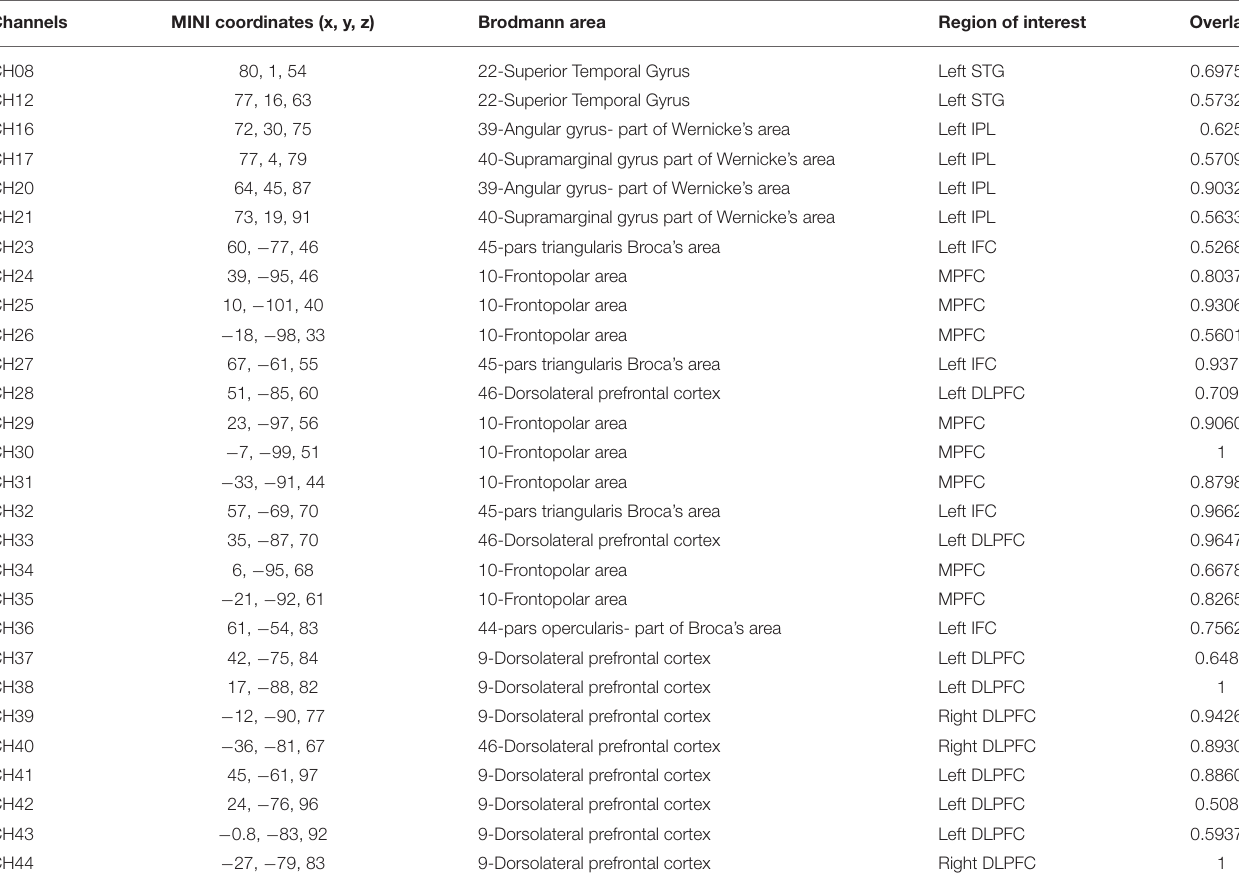
TABLE 1 | Mean channel locations for the fNIRS cap. Channels